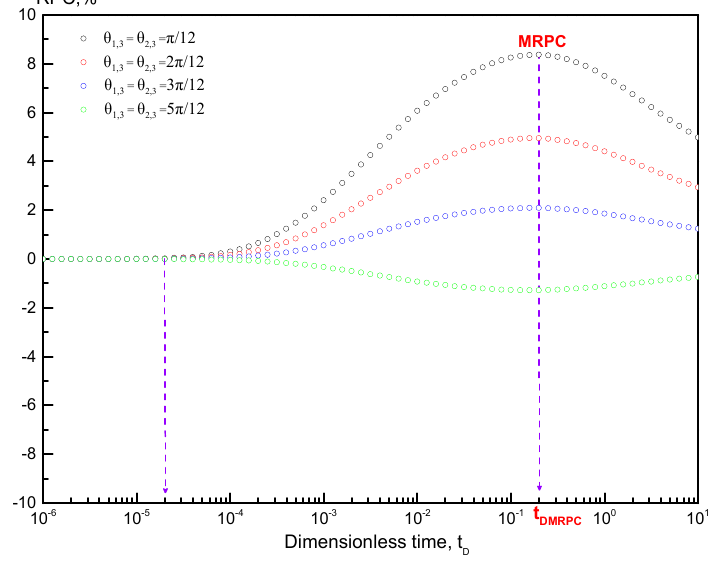
Figure 11. Effect of the reoriented fracture angle on pressure and the pressure derivative.